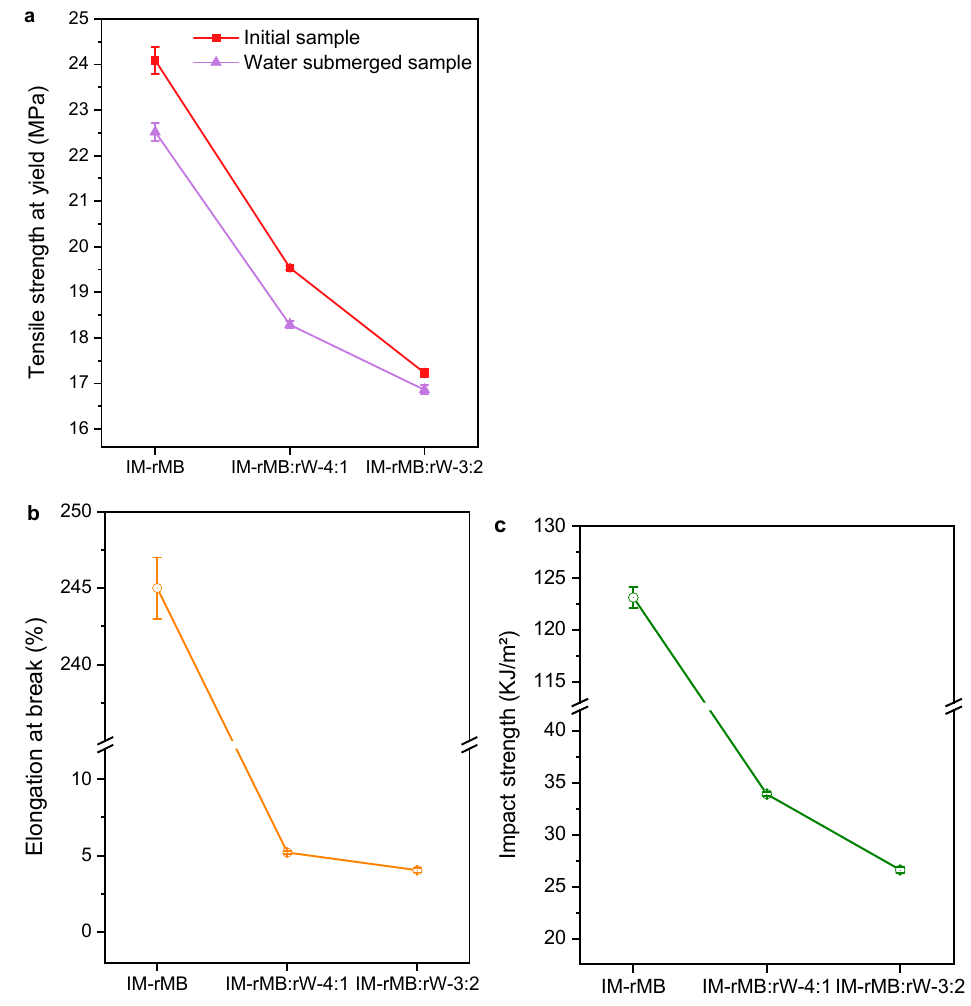
Figure 5. ( a , b ) Tensile and ( c ) impact properties of injection-molded wood–plastic composites.